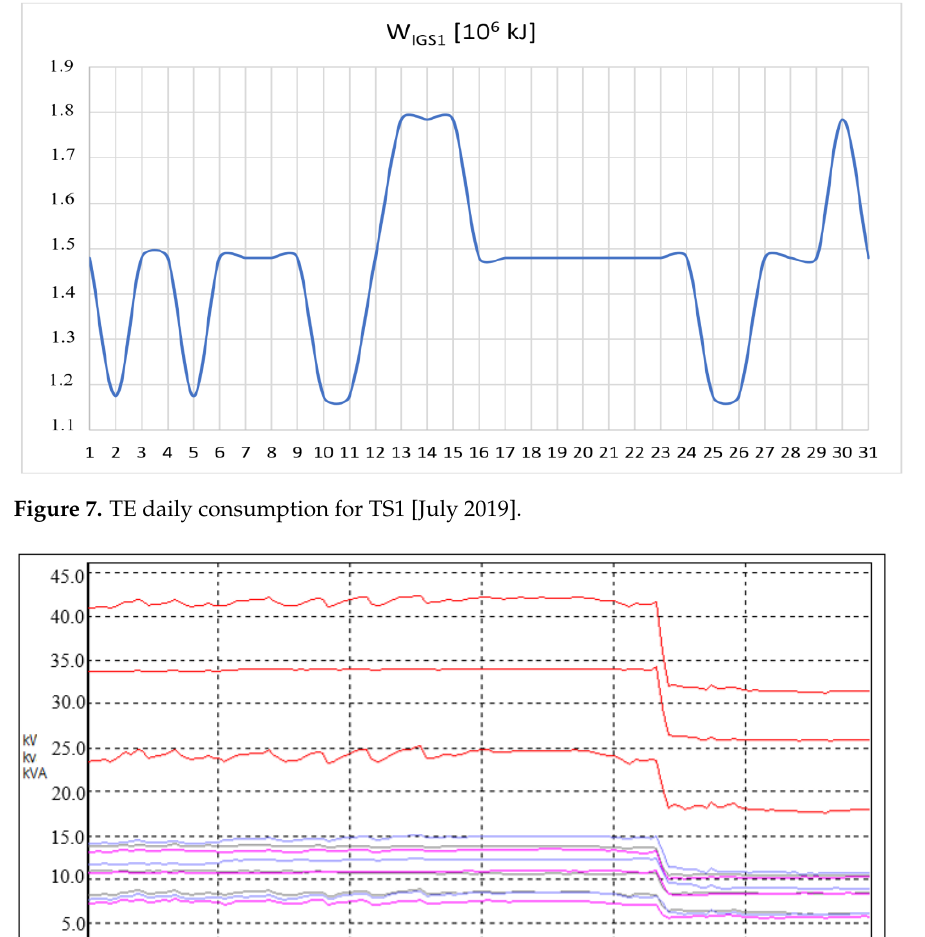
Figure 9. HEx1 geothermal water inlet pipe.